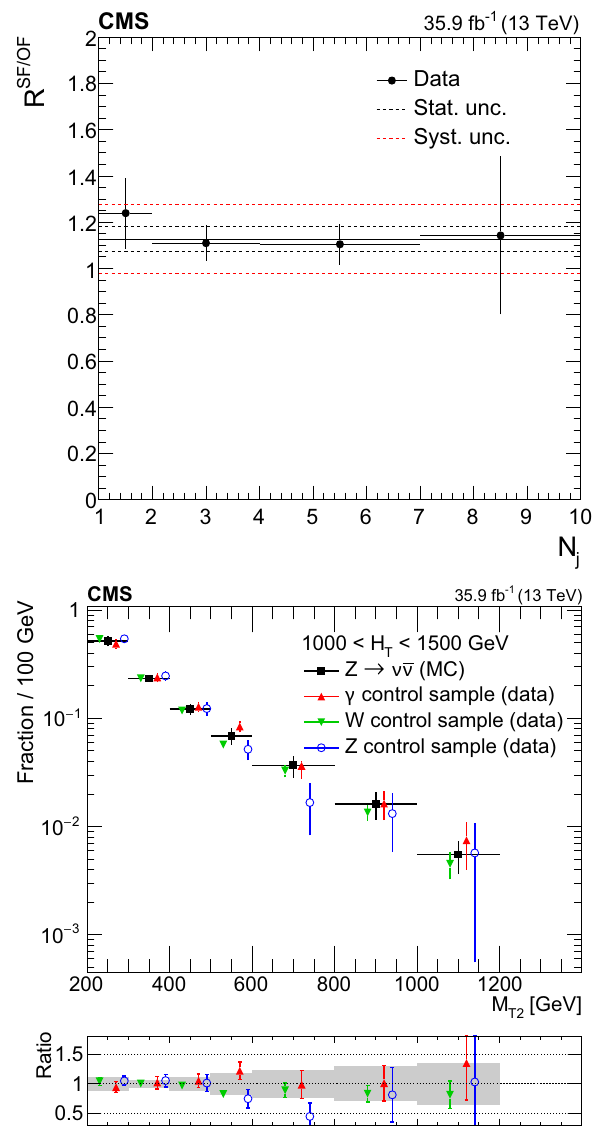
Fig. 2 (Upper) Ratio R SF / OF in data as a function of N j . The solid black line enclosed by the red dashed lines corresponds to a value of 1 . 13 ± 0 . 15thatisobservedtobestablewithrespecttoeventkinematics, while the two dashed black lines denote the statistical uncertainty in the R SF / OF value. (Lower) The shape of the M T2 distribution in Z → νν simulation compared to shapes from γ , W, and Z data control samples in a region with 1000 < H T < 1500GeV and N j ≥ 2, inclusive in N b . The solid gray band on the ratio plot shows the systematic uncertainty in the M T2 shape